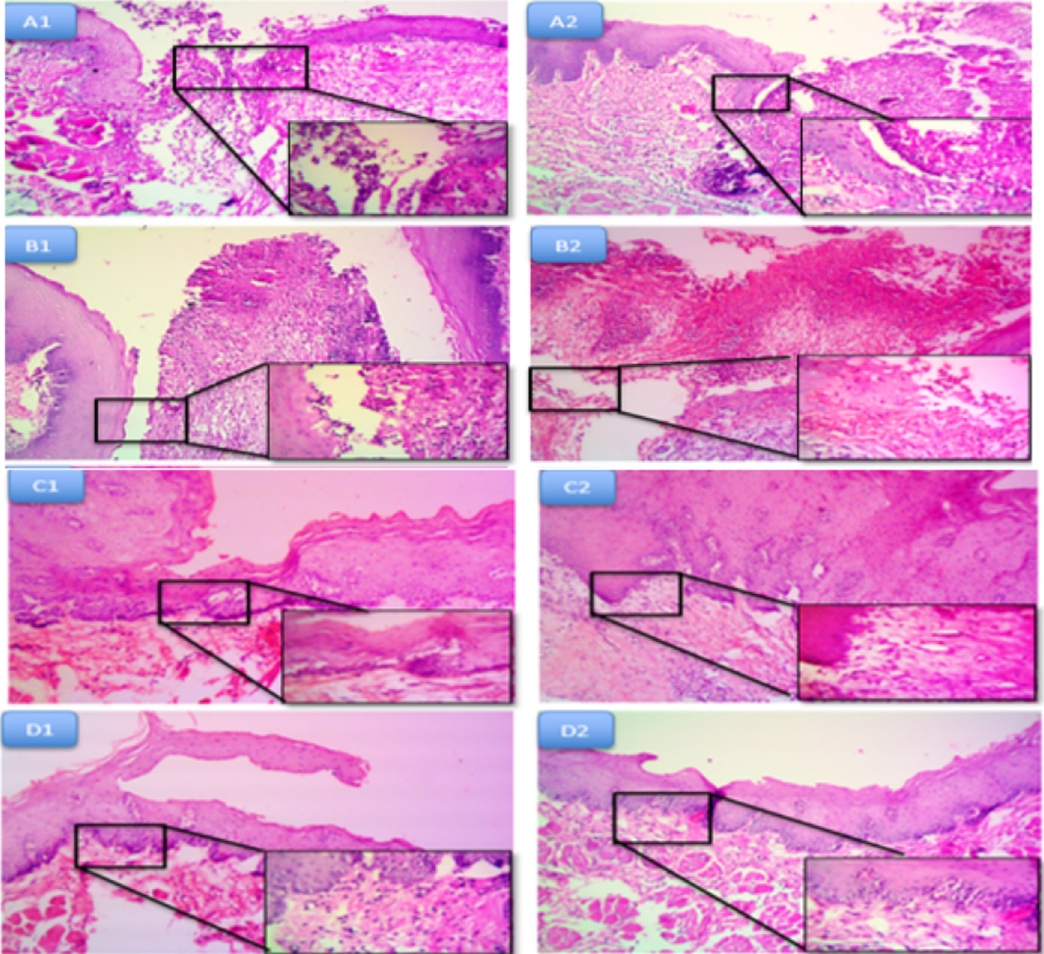
Fig. 1. Photomicrographs of rabbit oral mucosa for histopathological examination. A1&2: Control and treatment group respectively at one-day interval reveals heavy in fi ltration of in fl ammatory cells. B1&2: Control and treatment group respectively at three-day interval reveals slightly decrease of in fl ammation in treatment group compared to control group. C1&2; D1&2: Control and treatment group at seven-day interval and control and treatment group at 10-day interval respectively show superior healing process and decreasing of in fl ammatory reaction and formation of granulation tissue more regular than control group. H&E stain, 100 (cid:3) , 400 (cid:3)